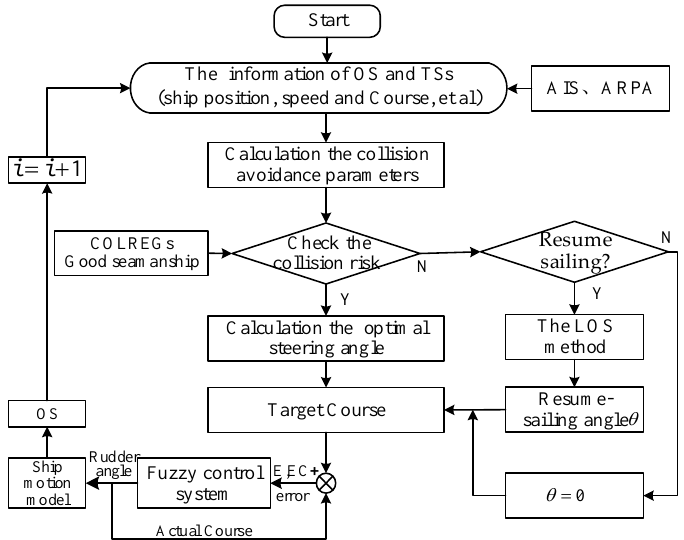
Figure 5. Flowchart of the adaptive autonomous collision avoidance